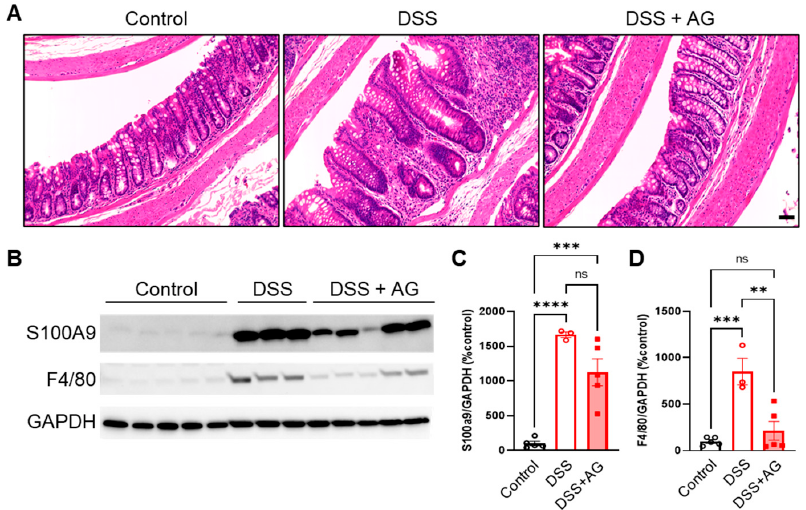
Figure 2. Ghrelin treatment reduces colon inflammation post-induction of DSS-induced colitis in old mice. ( A ) Representative photographs (around the mid-section) of the colons were collected on day 14 from the control, DSS and DSS + AG groups. Scale bar = 50 µ m. Colon homogenates were assayed for S100A9 ( B , C ) and F4/80 ( B , D ) protein levels using western blot analysis. Data were analyzed with one-way ANOVA (treatment) followed by Tukey’s post-hoc tests, ** p < 0.01, *** p < 0.001, **** p < 0.0001. AG: acyl-ghrelin; DSS: dextran sulfate sodium; ns: not significant.